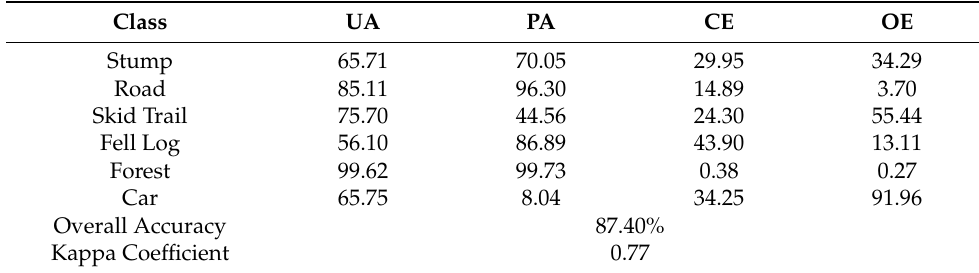
Table 7. Support vector machine classification accuracy.